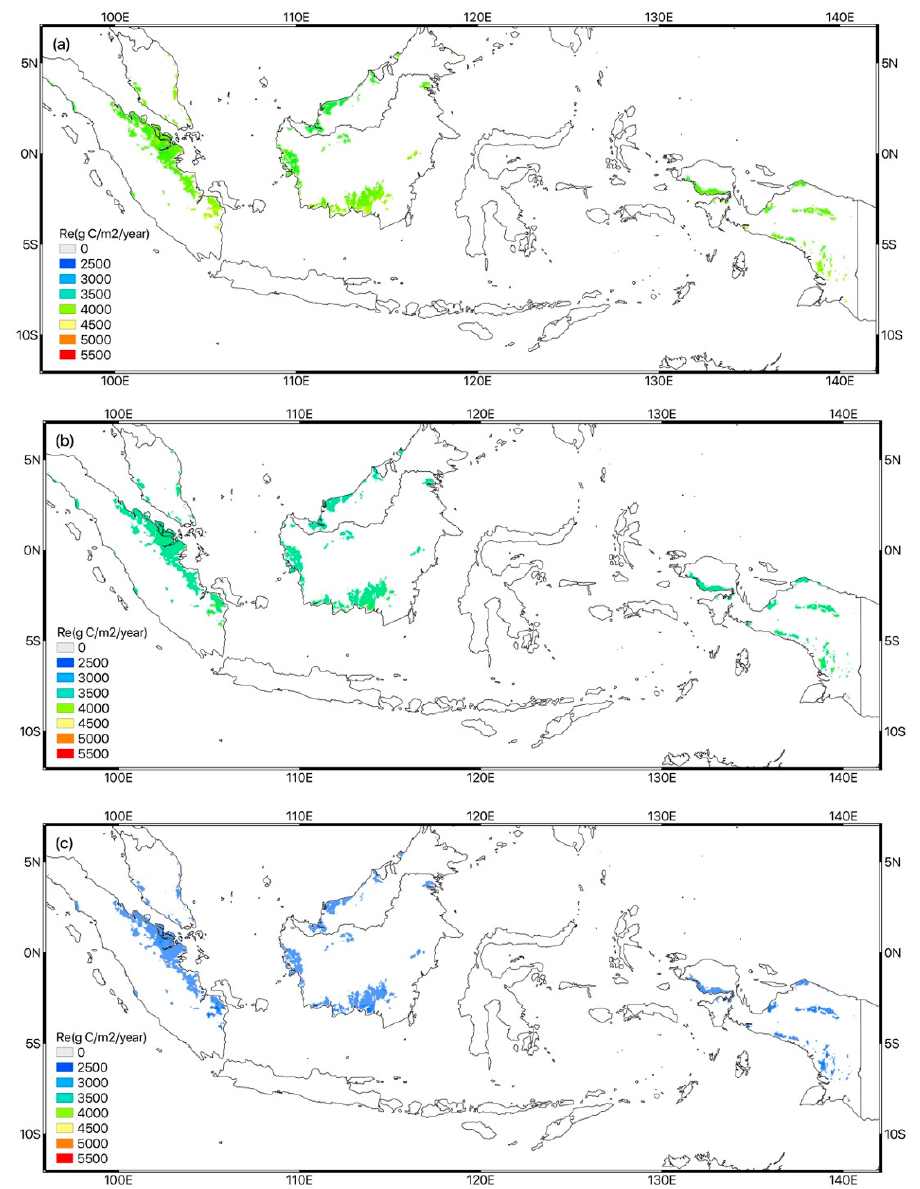
Figure 7. Spatial distributions of annual average ecosystem respiration ( R e ) from 2002 to 2018 in three cases created using ( a ) undrained forest ( UF ), ( b ) drained forest ( DF ), and ( c ) burned forest ( BF ) equations.